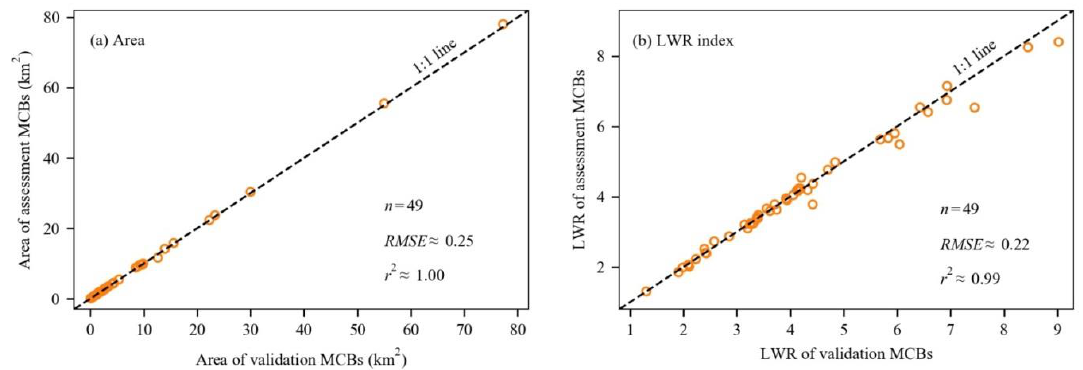
Figure 4. Accuracy assessment of MCBs for area ( a ) and LWR index ( b ).